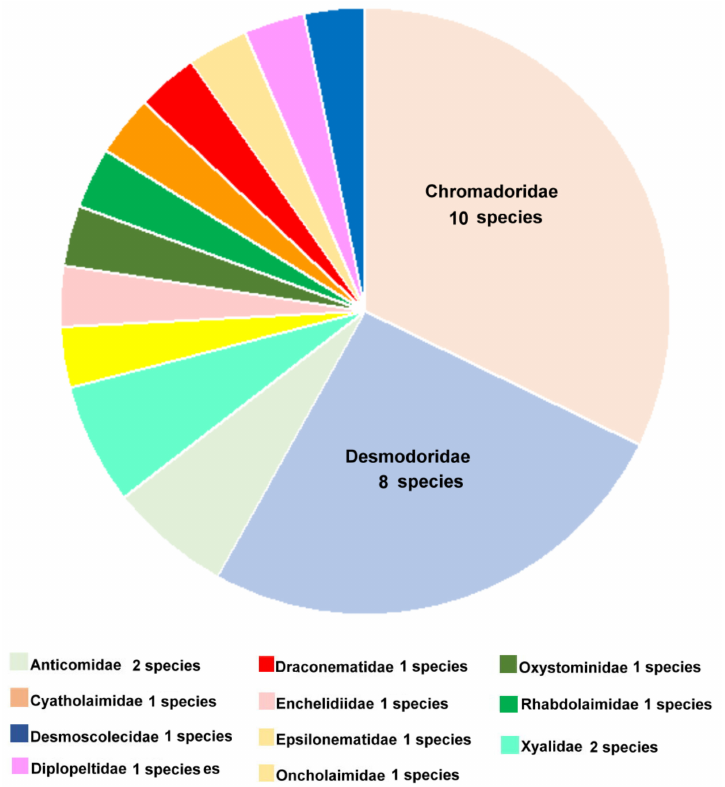
Figure 15. Species diversity in families constituting total nematode population in